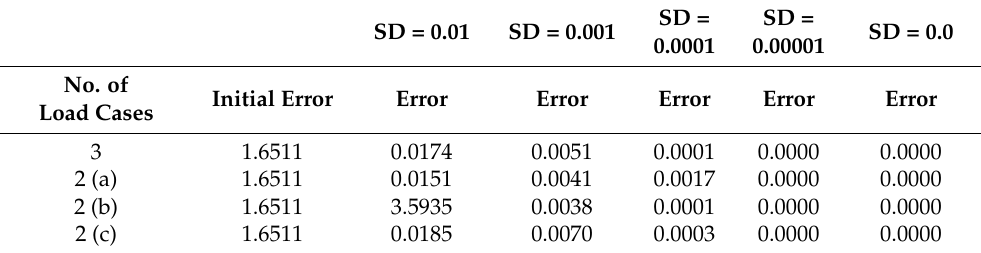
Table 2. Errors obtained for predicted temperatures for steady state 4 nodes model.